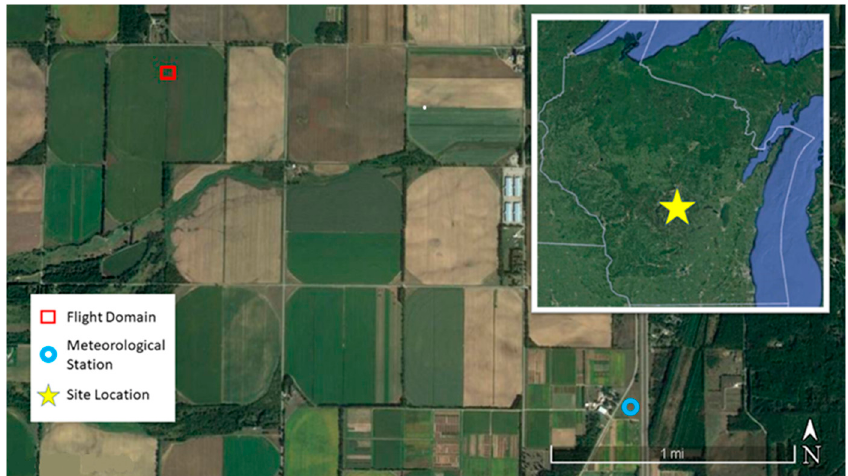
Figure 1. Map of 2019 study site. Flight domain is centered around an EC tower. The meteorological station was located 3.9 km southeast of the site. Aerial imagery provided by Google